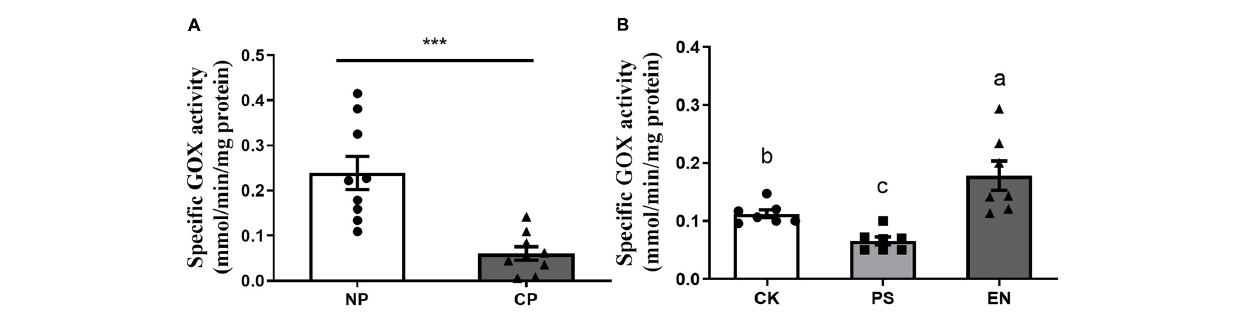
FIGURE 3 | Effect of parasitism and bacterial inoculation on glucose oxidase activity in the labial glands of fall armyworm. (A) Glucose oxidase (GOX) activity in the labial glands of caterpillars was measured at day 5 after parasitism. NP, caterpillars without parasitism; CP, caterpillars parasitized by C . marginiventris . Values are untransformed mean ± SEM ( t = 4.497; p = 0.0004; n = 9; unpaired t -test). The asterisk indicates significant differences between treatments (*** p < 0.001). (B) GOX activity in the labial glands of fall armyworm with or without bacterial inoculation. Values are untransformed mean ± SEM ( F 2 , 18 = 13.09, p < 0.001; n = 7, Fisher’s test). Different letters indicate significant differences between